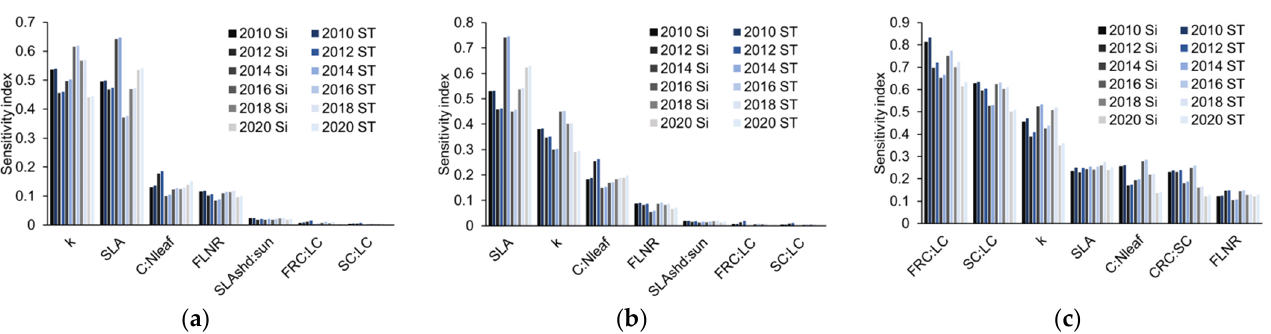
Figure 1. First-order sensitivity index (S i ) and total sensitivity index (S Ti ) of key parameters during 2010–2020 with different outputs: ( a ) with NEE as the output; ( b ) with GPP as the output; ( c ) with LAI as the output.